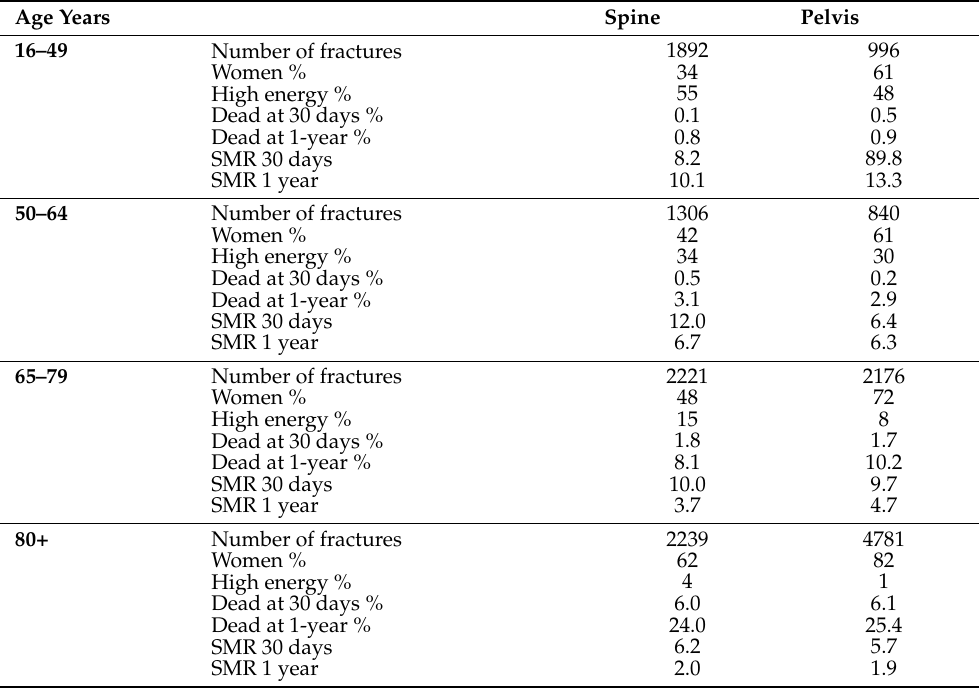
Table 3. Numbers of fractures, proportion of women (% total) and high-energy trauma (% total), mortality rate per time point after fracture, and standardized mortality ratios (SMR) per time point after fracture for spine and pelvic injuries by age